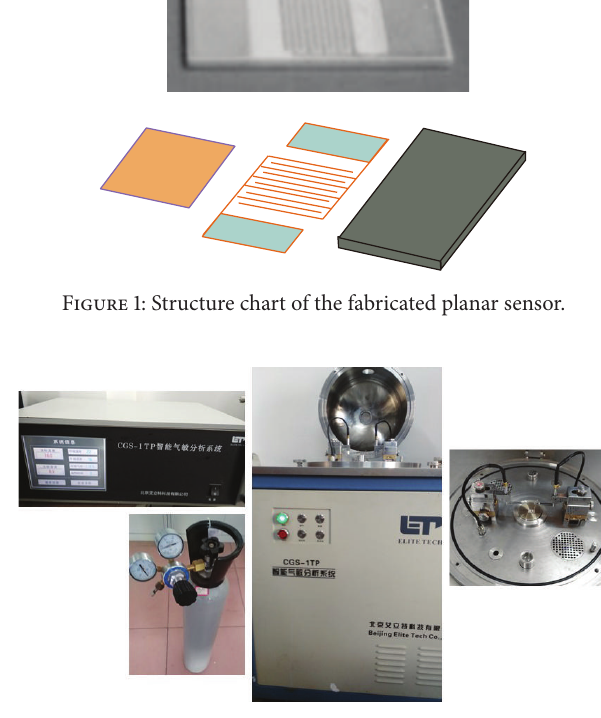
Figure 2: The CGS-1TP gas sensing analysis